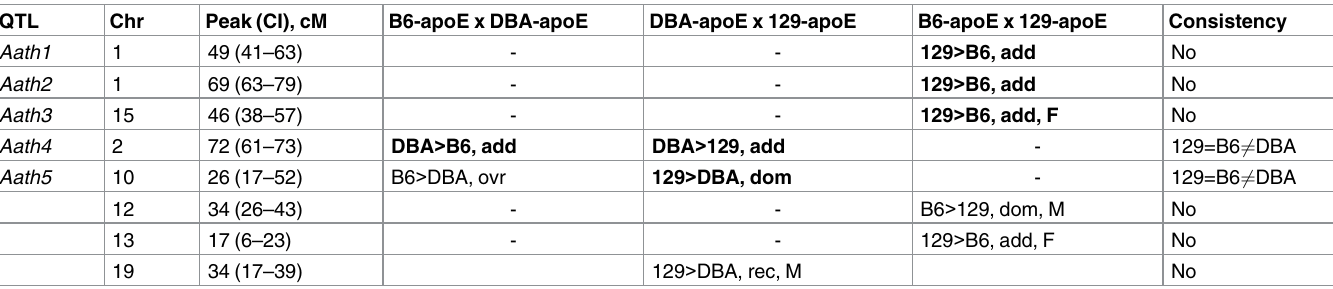
Table 3. QTLs for atherosclerotic lesions at arch in three F2 intercrosses of Apoe-null mice on B6, DBA and 129